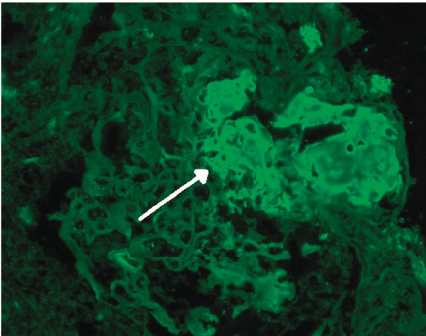
Figure 4: This section is stained for fibrinogen and kappa and lambda light chains. There is focal and segmental staining of glomeruli with fibrinogen, in areas of crescents/fibrinoid necrosis (arrow). Kappa and lambda stain equally throughout the